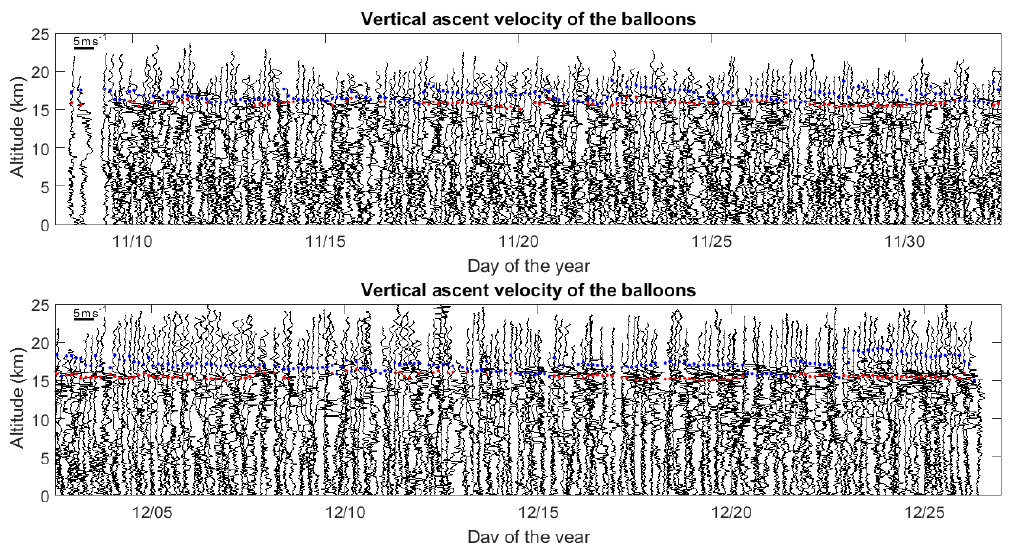
Figure 8. Vertical profiles of V B from 376 consecutive balloons launched about every 3h from 8 November to 27 December 2015 during the pre-YMC campaign at Bengkulu (102.26 ◦ E, 3.79 ◦ S; Indonesia); 0.5d corresponds to 5ms − 1 , and each profile was shifted by about 0.125d (1.25ms − 1 ). The cold point temperature tropopause and a secondary temperature inversion of similar intensity at lower altitude are shown as blue and red dots, respectively.